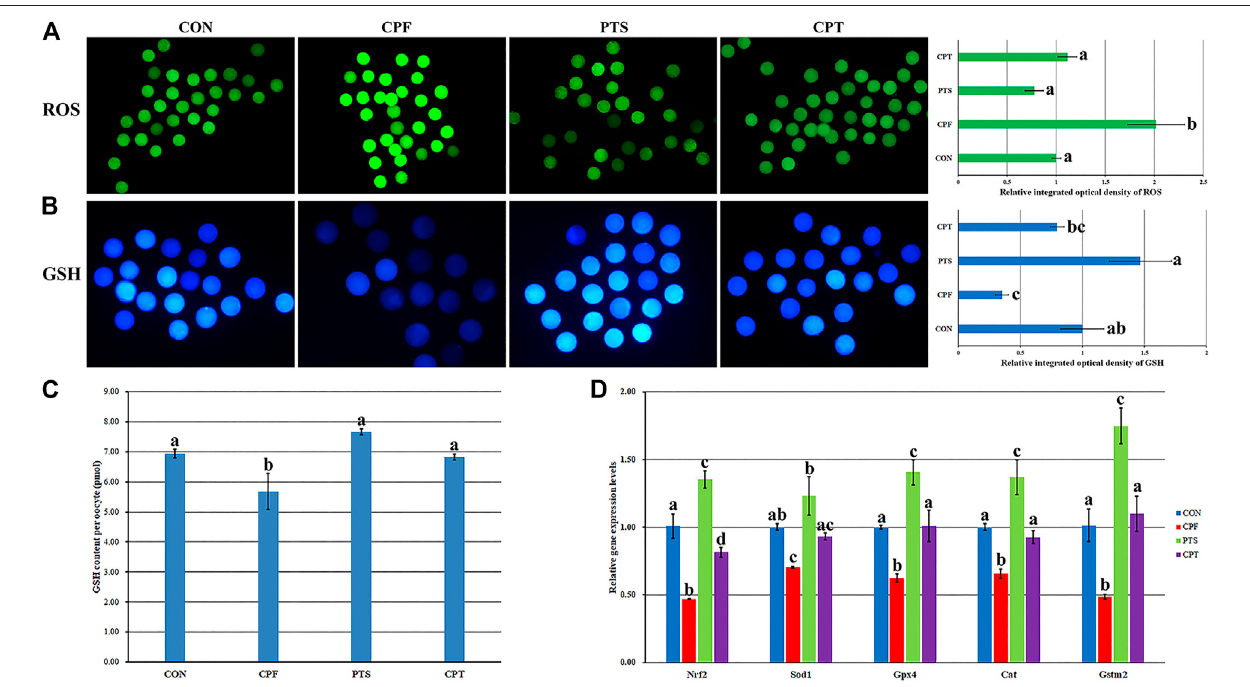
FIGURE 5 | Effect of CPF and PTS on oocyte ROS and GSH content. (A) , fl uorescence and relative integrated optical density of ROS ( × 40). (B) , fl uorescence and relativeintegratedopticaldensity ofGSH ( × 100). (C) ,GSHcontentper oocyte. (D) ,relativeexpression ofredox related genes. a-d Values foracertain groupwith different superscripts differ signi fi cantly ( p <